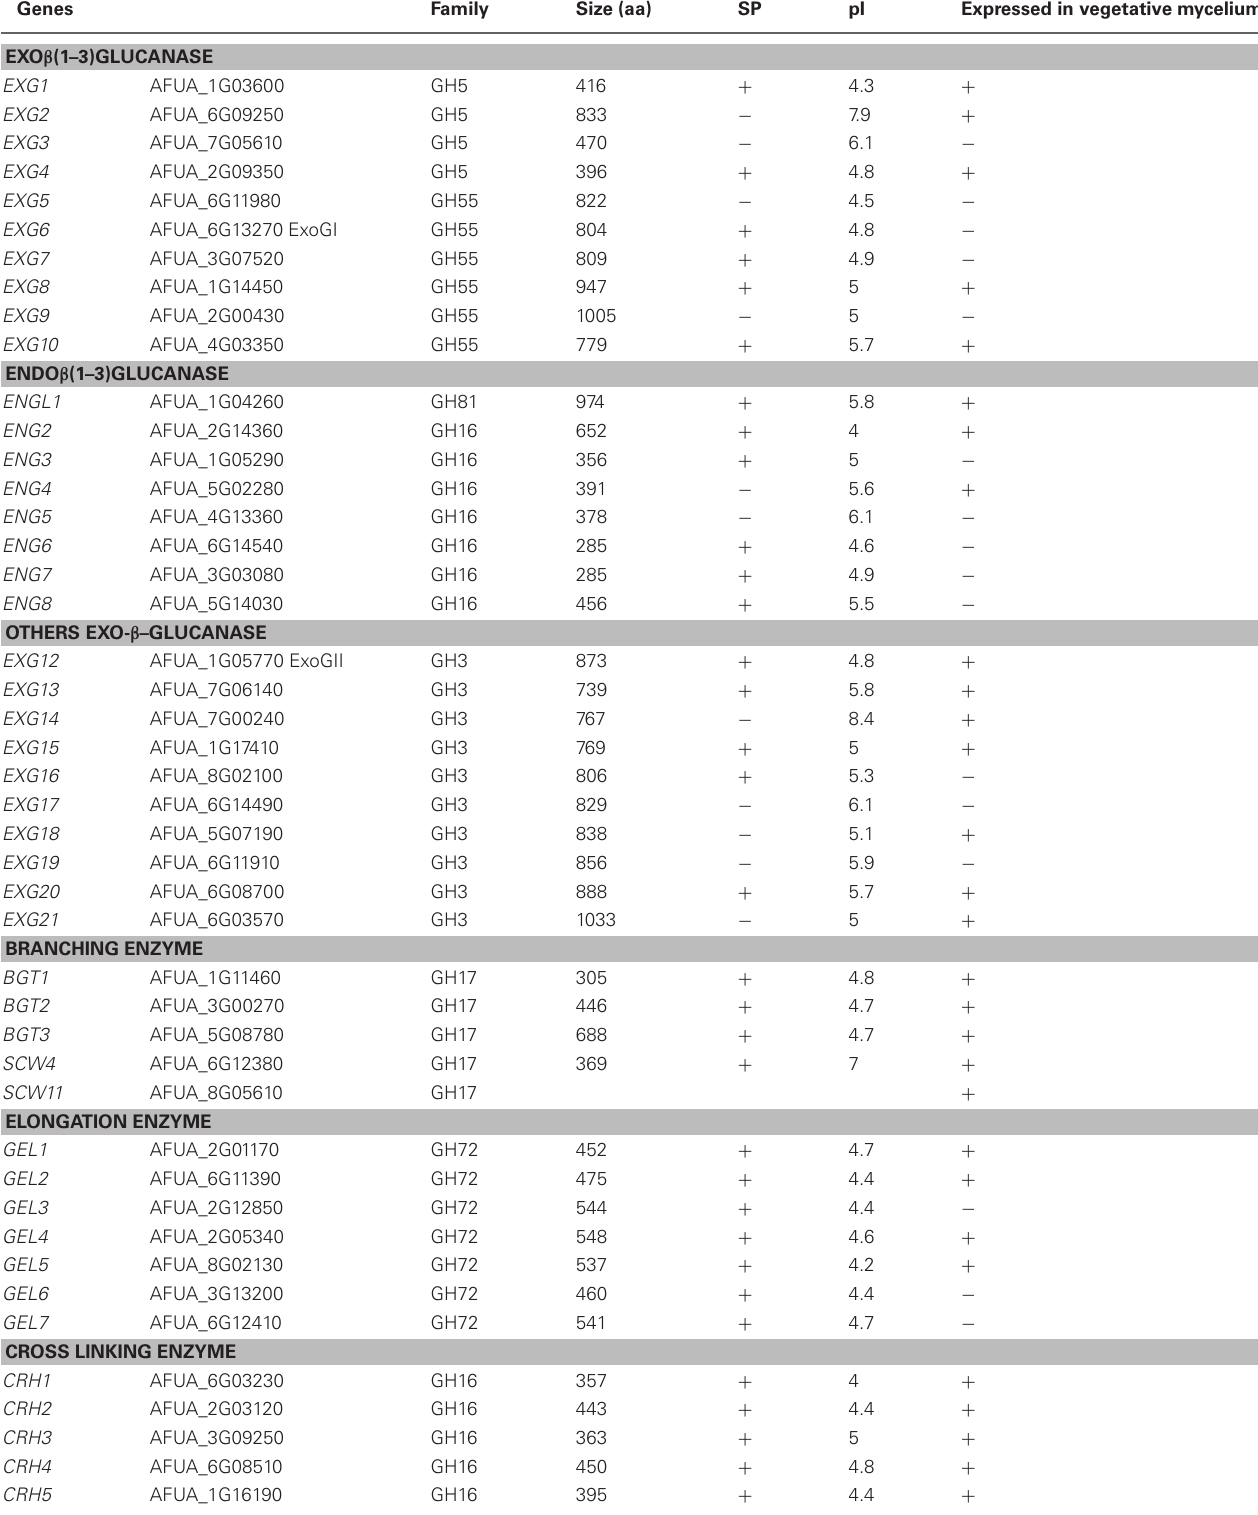
Table 1 | AFUA-number of A. fumigatus genes from Af293 strain (http://www.cadre-genomes.org.uk/Aspergillus_fumigatus) and characteristics of modifying cell wall β -1,3-glucanases of A. fumigatus. Genes Family Size (aa) SP pI Expressed in vegetative mycelium EXO β (1–3)GLUCANASE